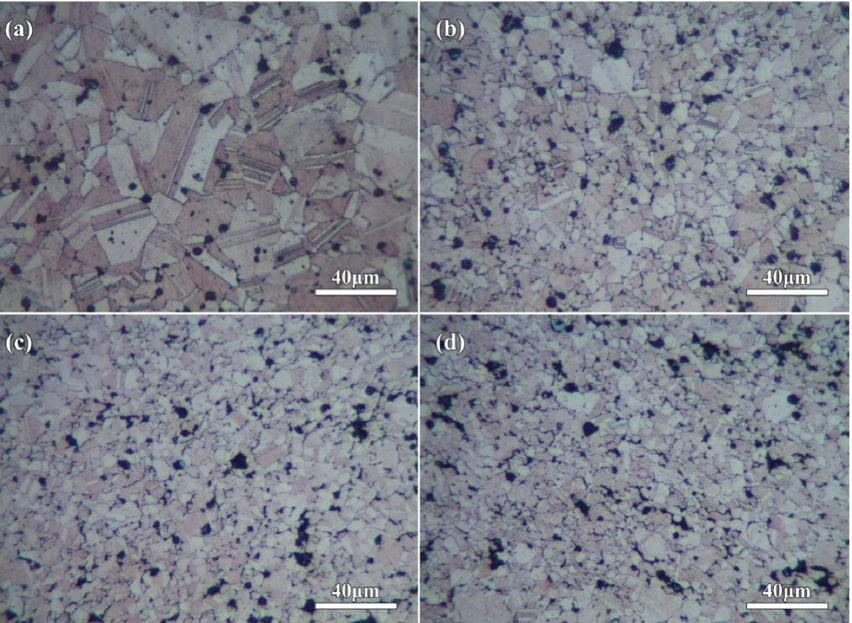
Figure 9. OM micrographs of the corroded compacts showing the refined Cu grains in rGO nanosheets added samples: ( a ) 0rGO, ( b ) 1rGO, ( c ) 2rGO, ( d ) 3rGO. added samples: ( a ) 0rGO, ( b ) 1rGO, ( c ) 2rGO, ( d )